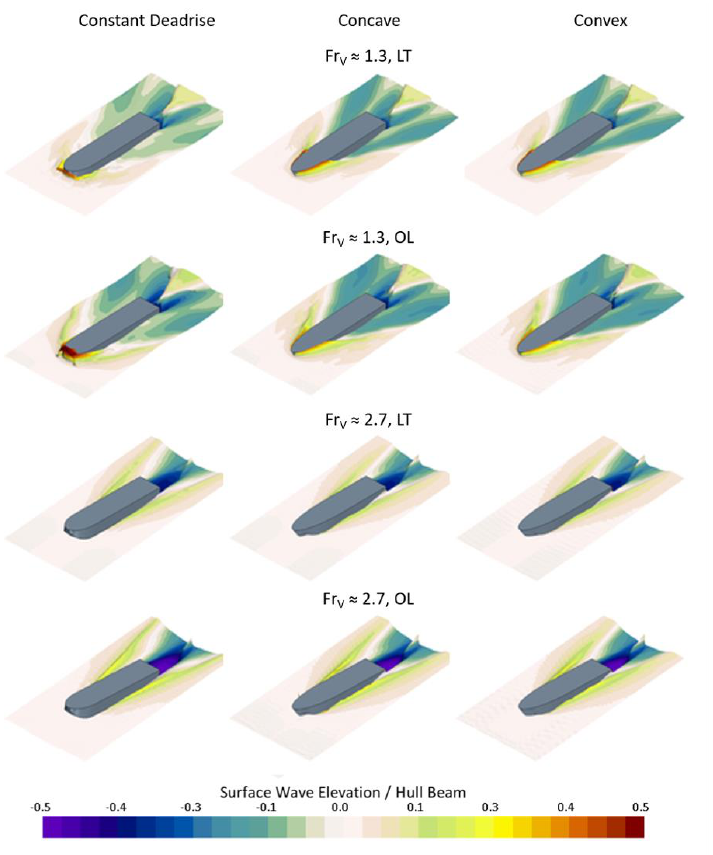
Figure 16. Comparison of near-hull waves for each hull form at LCG = 45% and Froude numbers 1.3 and 2.7 for both lighter (LT) and overloaded (OL) configurations.